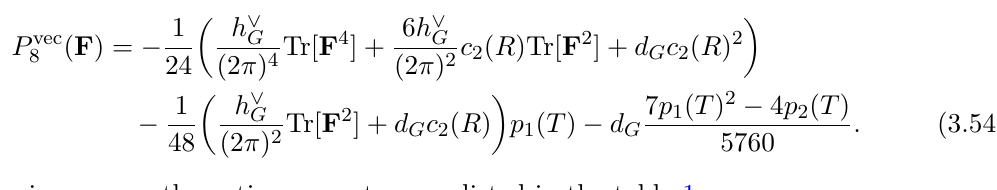
. The anomaly polynomial of a 0 ,N